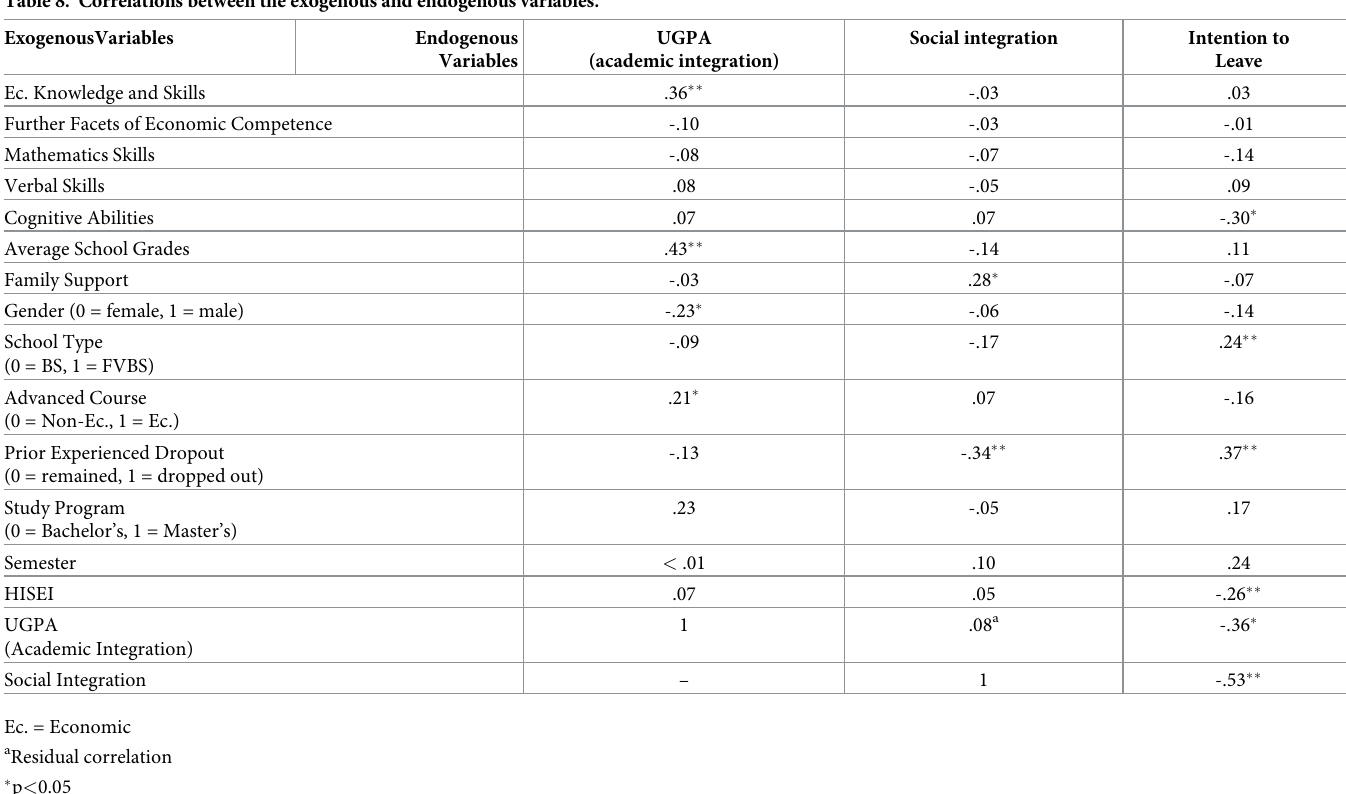
Table 8. Correlations between the exogenous and endogenous